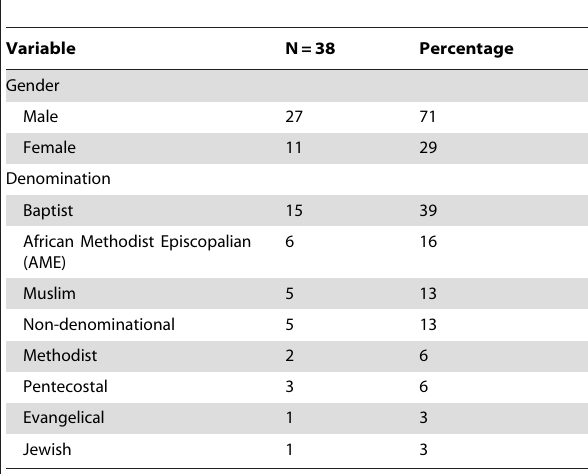
Table 1. Demographic Information and Religious Affiliation of Focus Group